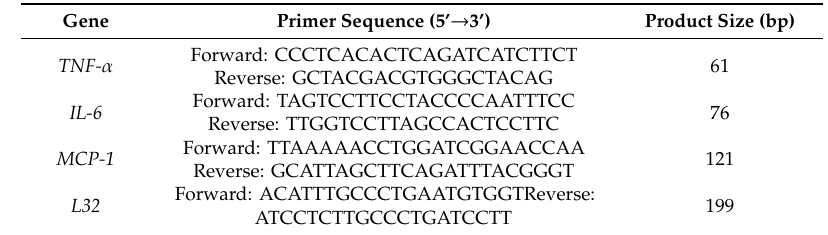
Table 1. Primers used for quantitative real-time reverse transcription polymerase chain reaction (RT-PCR).